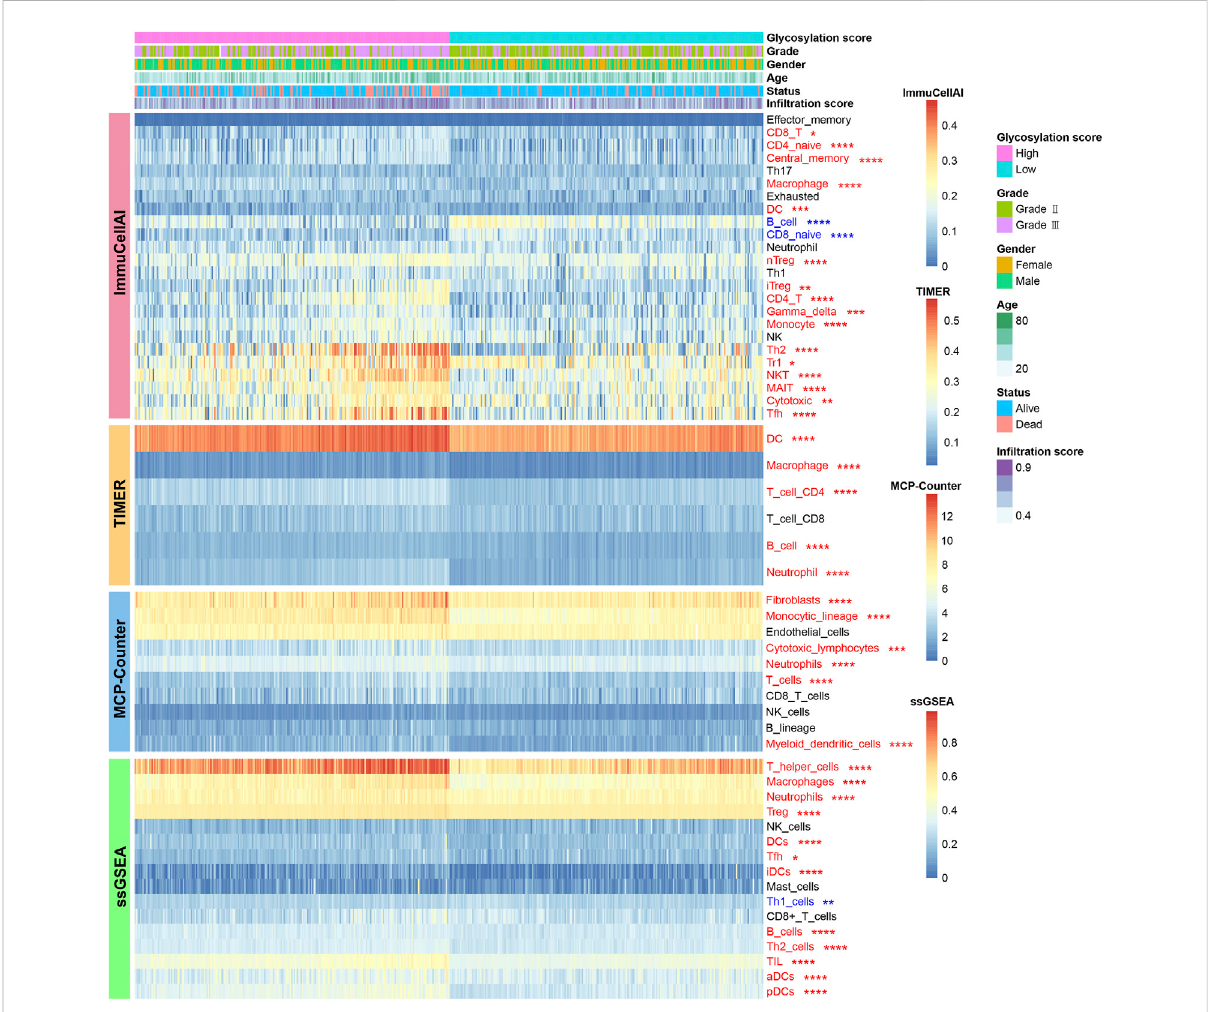
FIGURE 6 Landscapeofin fi ltratingcellsinthehighandlowglycosylationscoresubgroups.Theheatmapdepictedtheimmuneandstromalcellin fi ltration scores. Red represents cells in fi ltrated higher in the high glycosylation score subgroup and blue represents cells in fi ltrated lower in the high glycosylation score subgroup. * p < 0.05; ** p < 0.01; *** p < 0.001; **** p <